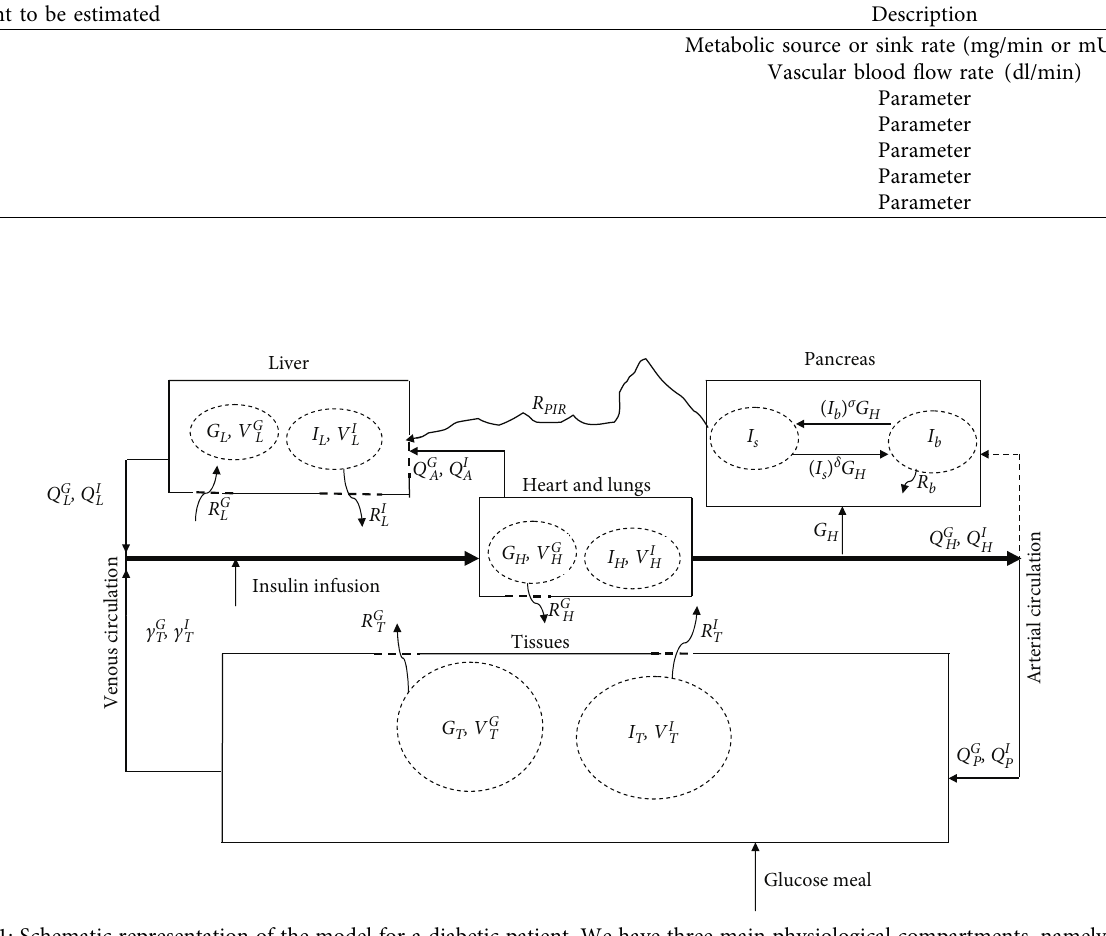
Figure 1: Schematic representation of the model for a diabetic patient. We have three main physiological compartments, namely, heart , liver , tissues , and pancreas . The tissues compartment is introduced as one compartment that contains four additional compartments (brain, kidney, gut, and periphery, i.e., skeletal muscle and adipose tissue, vascular-lymphatic system, skin, bones, and peripheral nervous system). The direction of blood flow is represented by the arrows which connect the physiological compartments. For notational purposes, we use subscripts in order to distinguish the physiological compartments. They indicate fluid spaces within